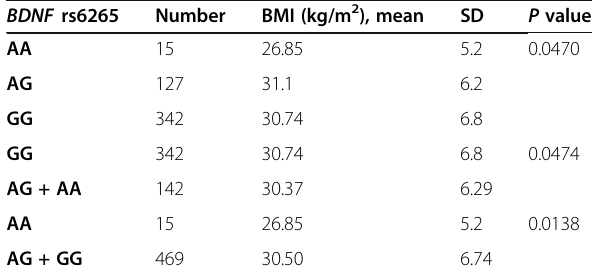
Table 3 BMI comparison by genotype and study group BDNF